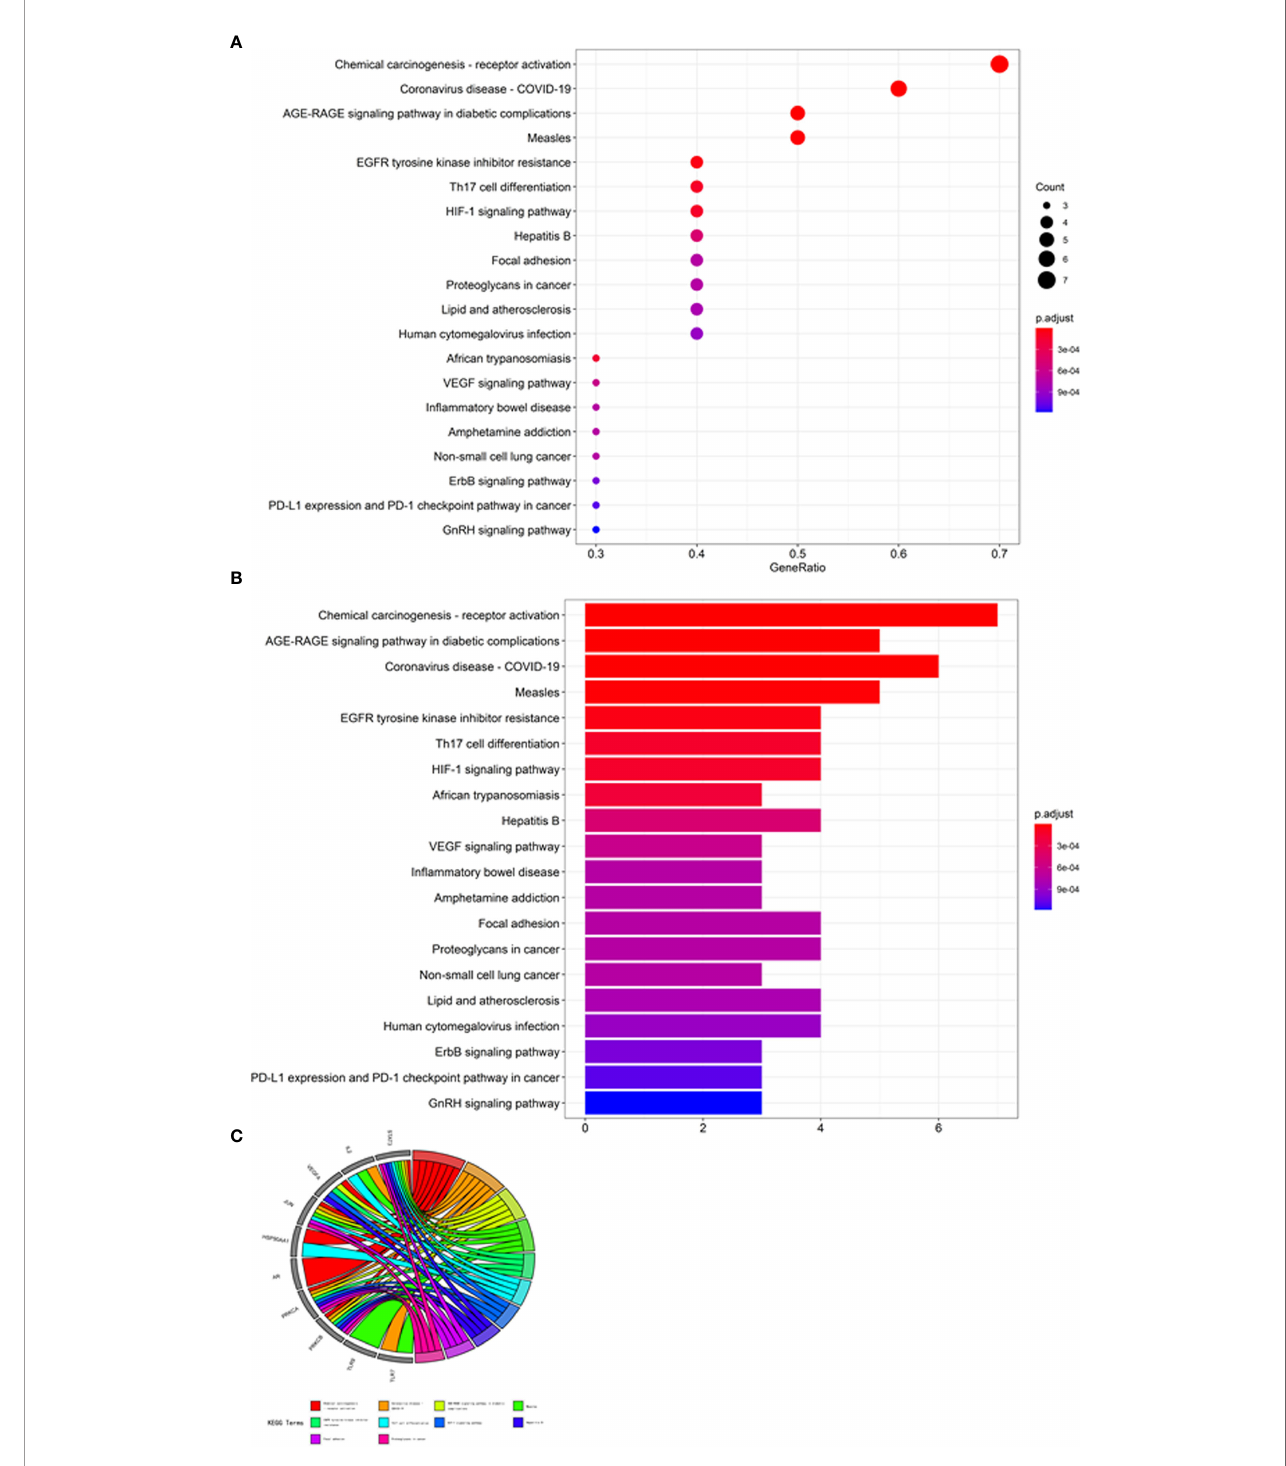
FIGURE 3 | KEGG enrichment analysis of core targets. Molecular mechanisms associated with KEGG signalling pathways are revealed in bubble chart (A) , bar chart (B) , and circle diagram (C) .